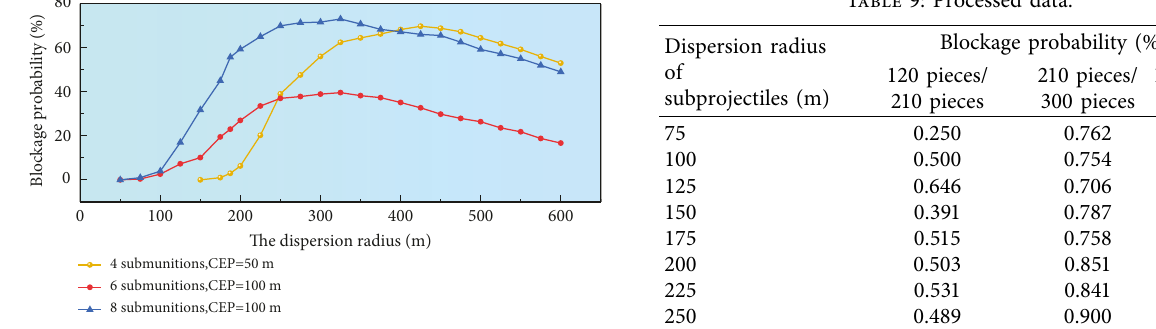
Figure 20: Influence of the dispersion radius of subprojectiles on the blockage probability under different preaiming point spacing of submunitions.